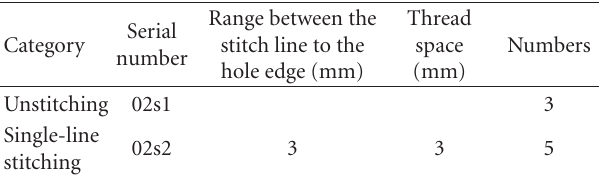
Table 1: Groups of the